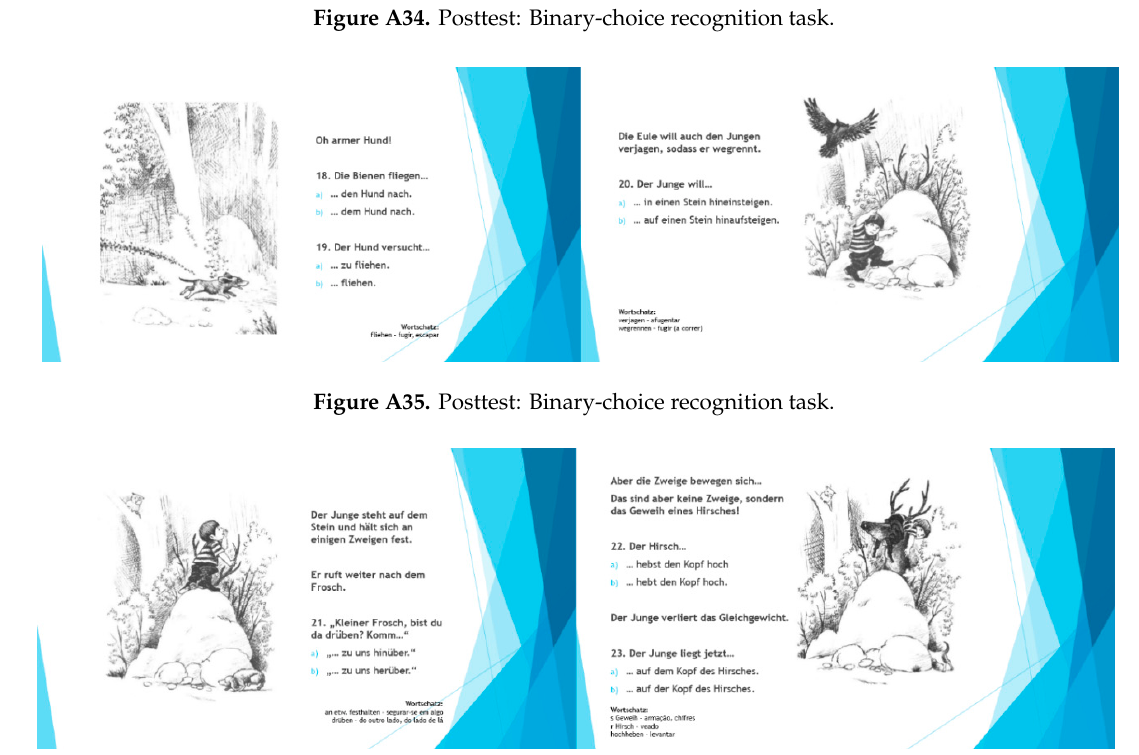
Figure A36. Posttest: Binary-choice recognition task.